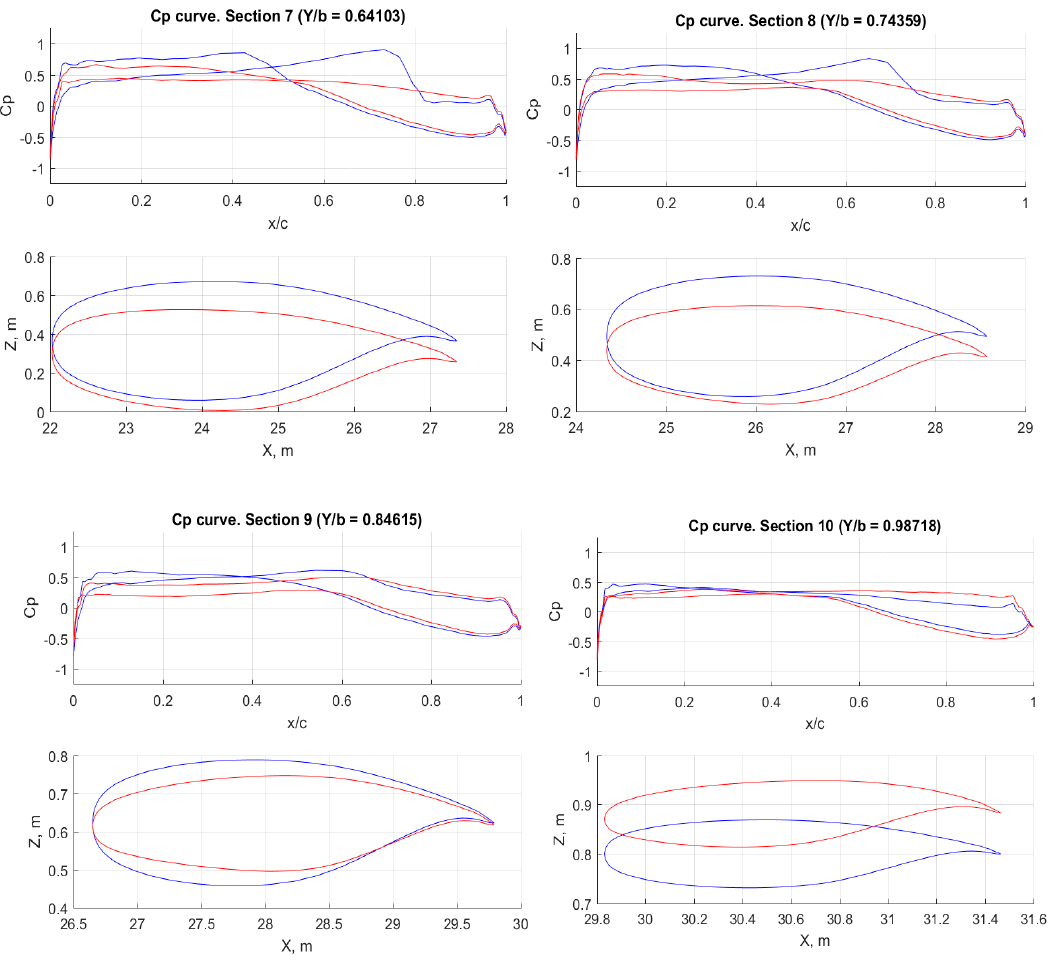
Figure 13. Pressure coefficient and geometry sections. Blue curves represent the initial design and red curves represent the optimized design.